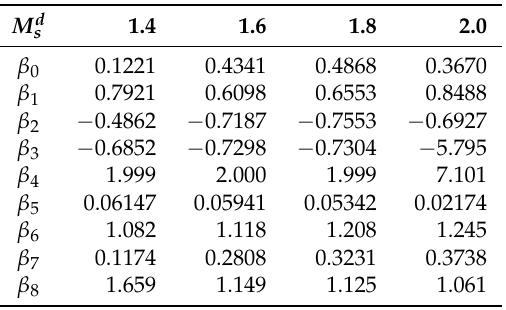
Table 2. Coefficient parameters β i ( M d s ) for τ i in the servo mode.